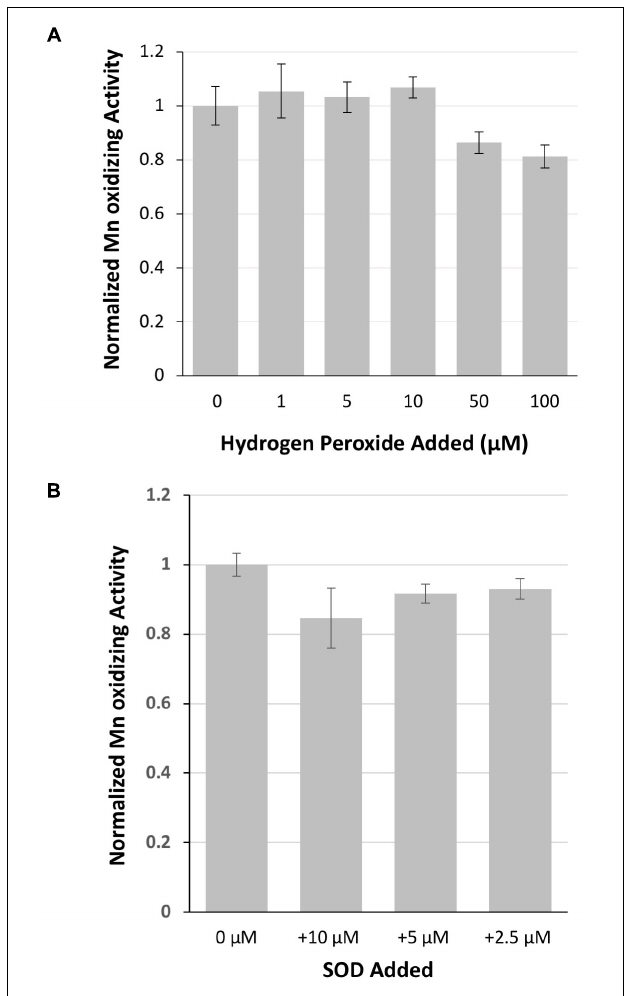
FIGURE 5 | The role of hydrogen peroxide and superoxide on MopA-hp catalyzed Mn(II) oxidation. (A) Hydrogen peroxide addition did not stimulate Mn(II) oxidation, and high concentrations of hydrogen peroxide inhibited activity. Activity normalized to no hydrogen peroxide added. (B) Superoxide dismutase (SOD), up to 10 µ M, has little effect on Mn oxidation. Activity normalized to no SOD added. Error bars represent ± one standard deviation of Mn oxidation assays run in